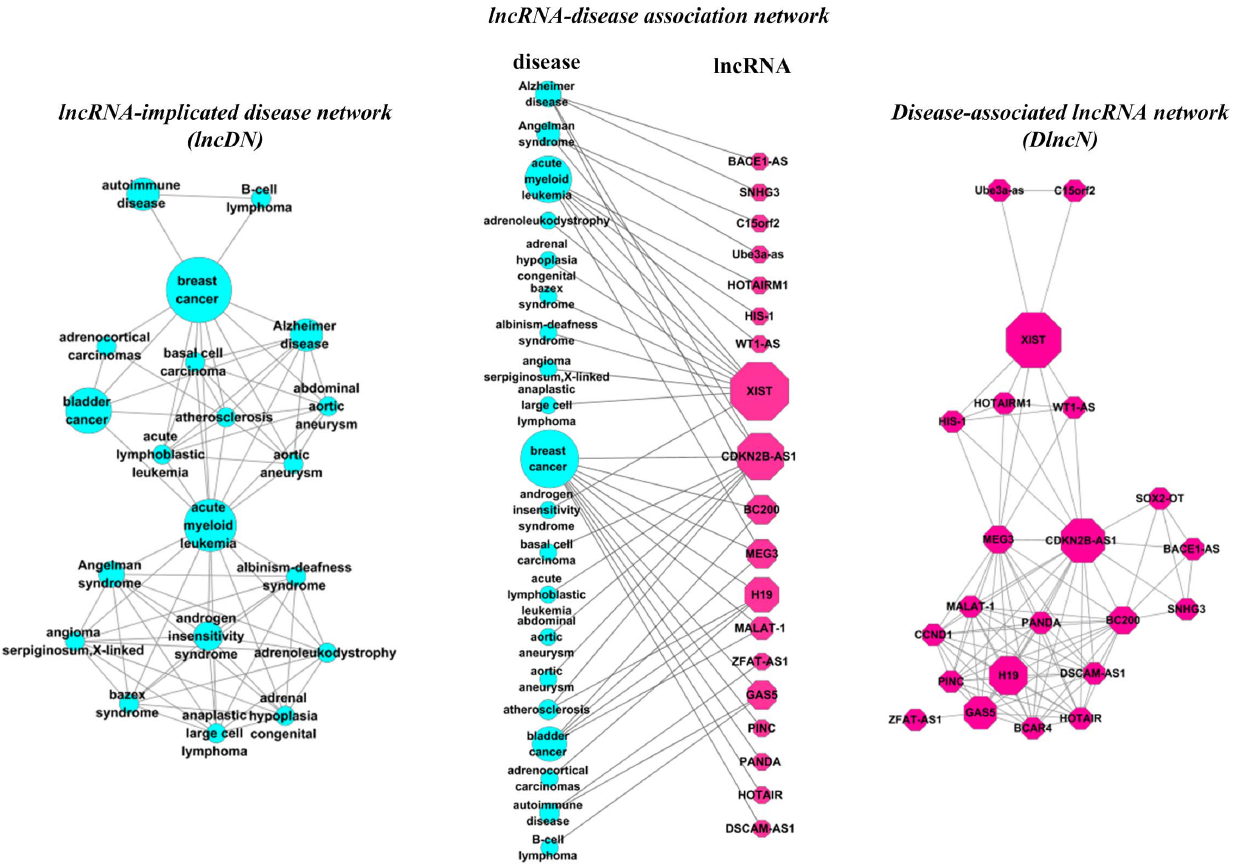
Figure 1. Construction of the lncRNA-disease bipartite network. (Center) A subnetwork of the full lncRNA-disease association network (Figure S1), where the blue circles and red hexagons correspond to diseases and lncRNAs, respectively. A link is placed between a disease and a lncRNA if mutations or dysfunctions in that lncRNA lead to the specific disease. The size of a blue circle is proportional to the number of lncRNAs participating in the corresponding disease. The size of a red hexagon is proportional to the number of diseases associated with the corresponding lncRNA. (Left) The lncDN projection of the center graph, in which two diseases are connected if there is a lncRNA implicated in both diseases. (Right) The DlncN projection of the center graph where two lncRNAs are connected if they are involved in the same